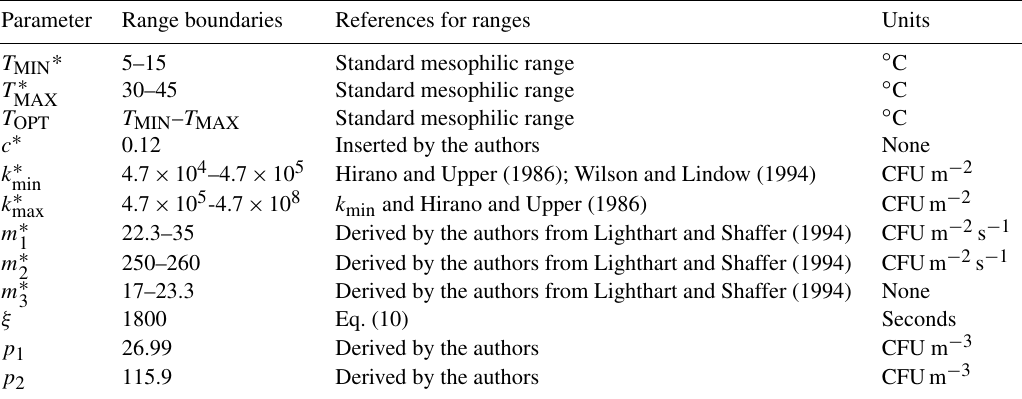
Table 1. Estimates for model parameters. The parameters tagged with an asterisk (*) are those that entered the calibration as unknowns from the initial guess, while the other parameters were